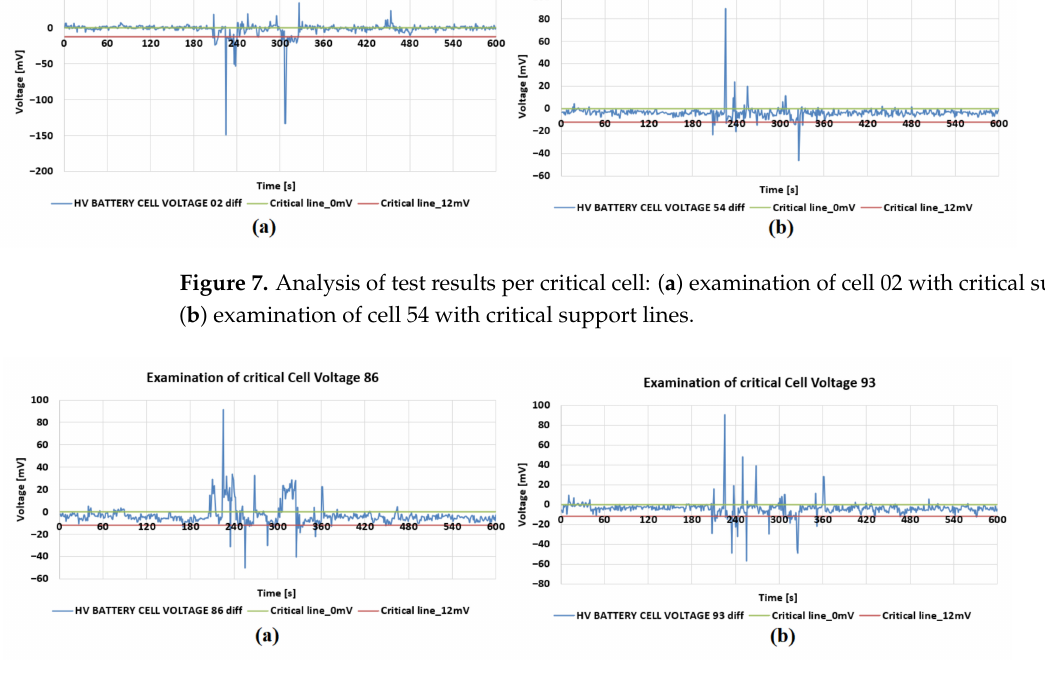
Figure 8. Analysis of test results per critical cell: ( a ) examination of cell 86, with critical support lines; ( b ) examination of cell 93, with critical support